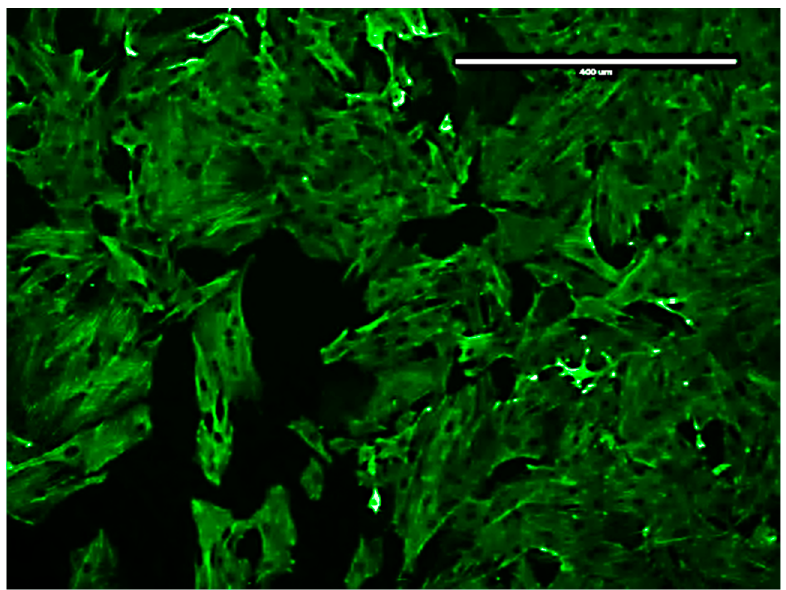
Figure A2. Immuno-stained microscopic image of rat aortic VSMCs depicting the presence of SM22 α actin fibers (scale bar: 400 µM, magnification: ×10).